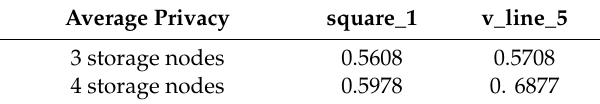
Figure 16. Evaluation results for dynamic clustering over the topology of 123 nodes for ( a ) 3 servers and v_line_5 trajectory, ( b ) 4 servers and v_line_5 trajectory, ( c ) 3 servers and square_1 trajectory, ( d ) 4 servers and square_1 trajectory. Table 5. Average privacy achieved by the walkthrough algorithm for the topology of 123 nodes.